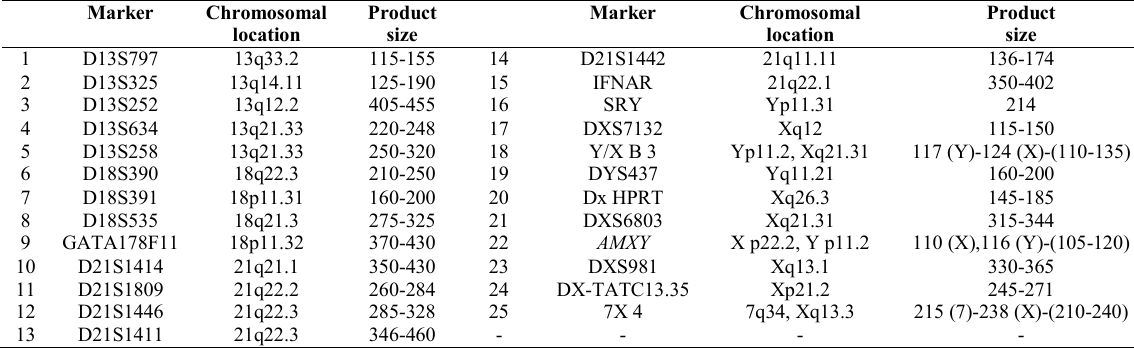
Table 1. Markers selected for QF-PCR detection of chromosome aneuploidies Marker Chromosomal